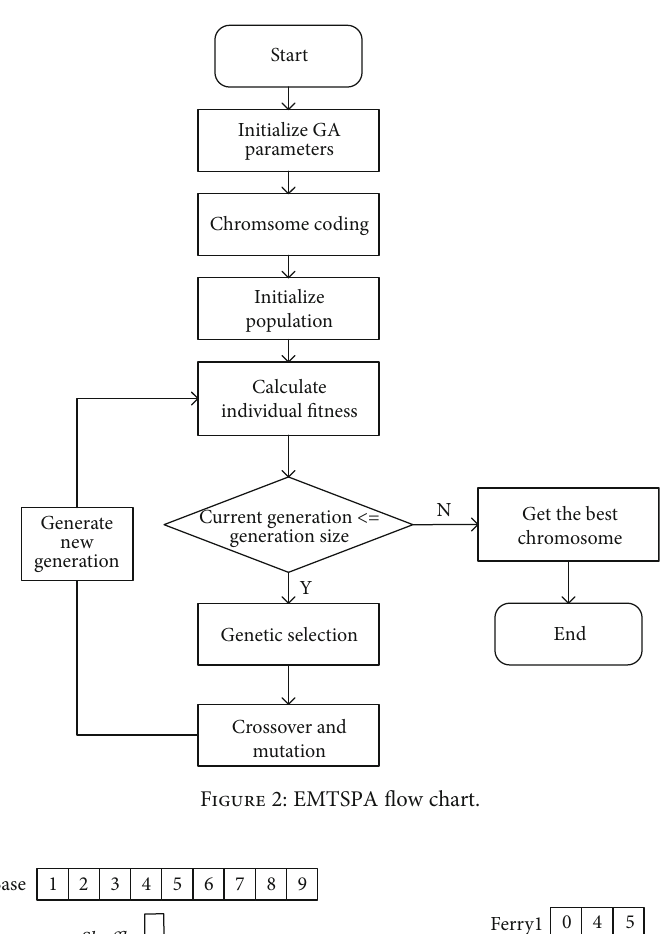
Figure 2: EMTSPA fl ow